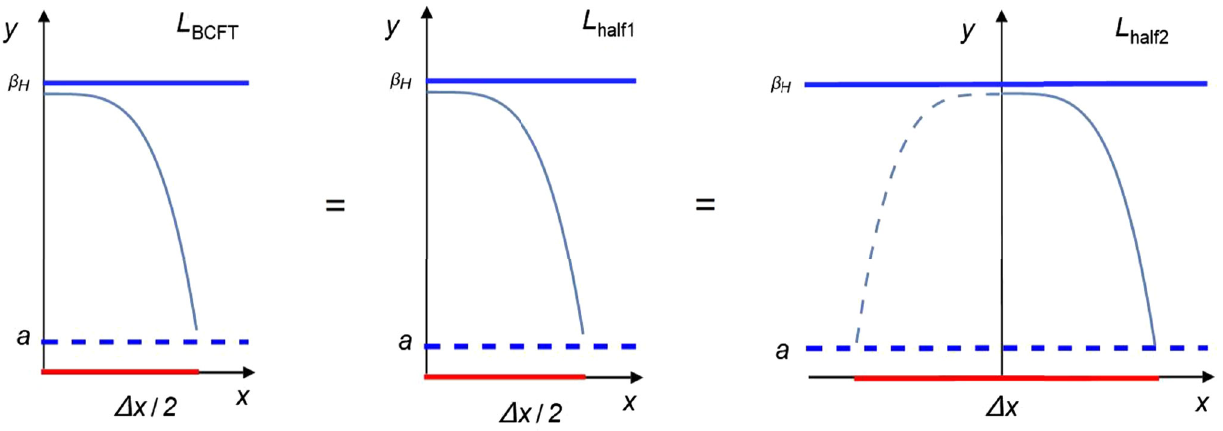
Fig. 1 The left picture is given by BCFT with (cid:7) x → ∞ . The middle picture is obtained from L bulk by setting y = a , y (cid:6) = β H and (cid:4) x / 2 → ∞ . The right picture is also given by L bulk from a different point of view, by setting y = y (cid:6) = a and (cid:7) x → ∞ . The solid lines in all three